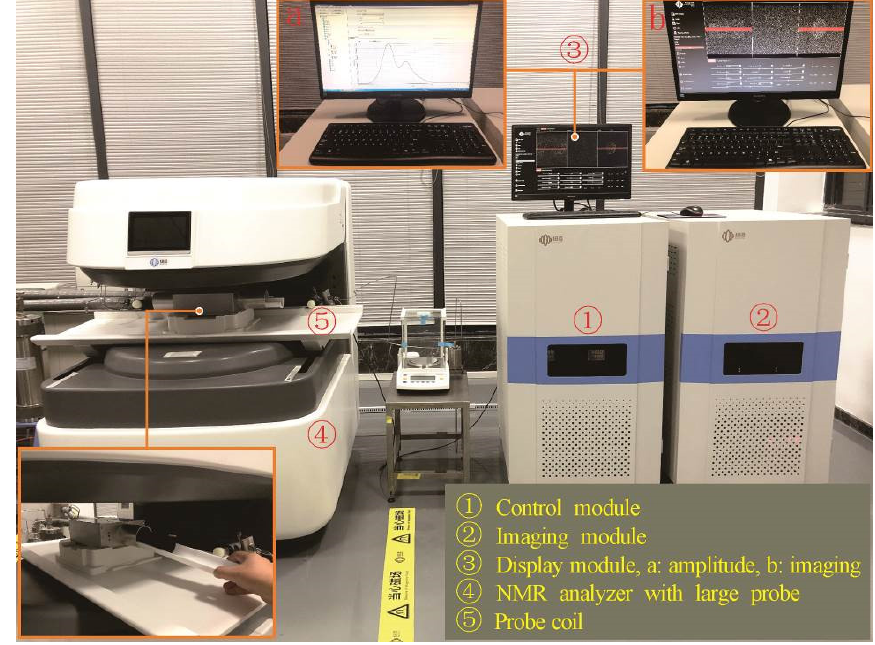
Figure 4. MR12-type low-field NMR analysis system: ( a ) the porosity and pore size distribution, ( b ) the pore and fissure imaging.